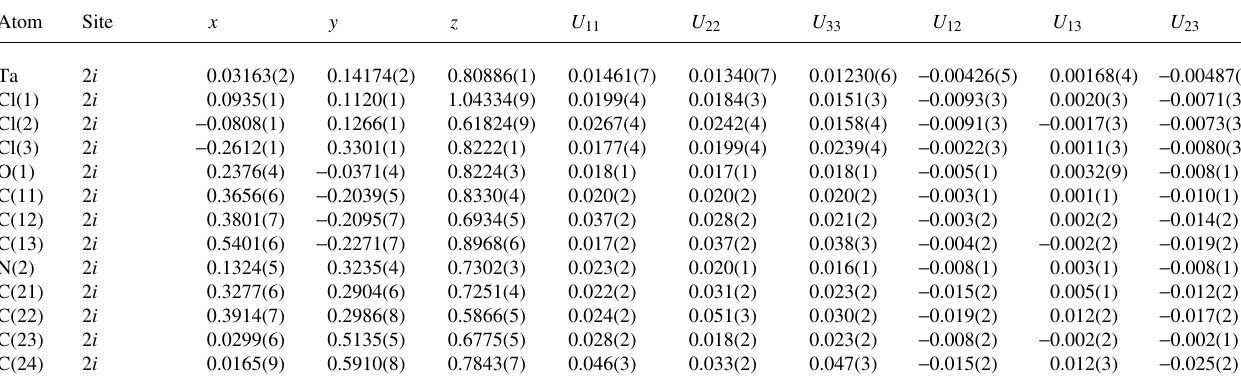
Table 3. Atomic coordinates and displacement parameters (in Å 2 )